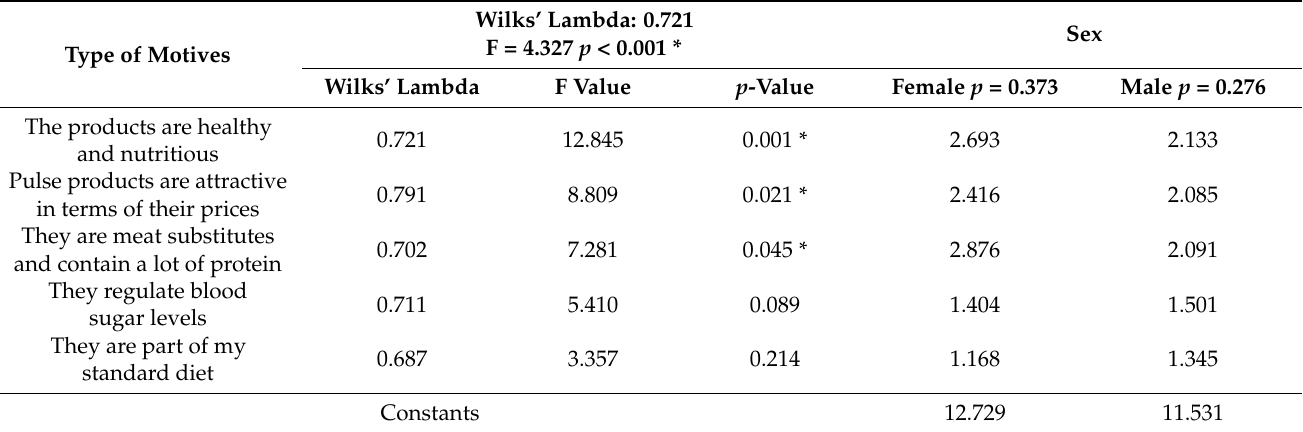
Table 3. Motives for consuming meals containing pulse products among consumers.